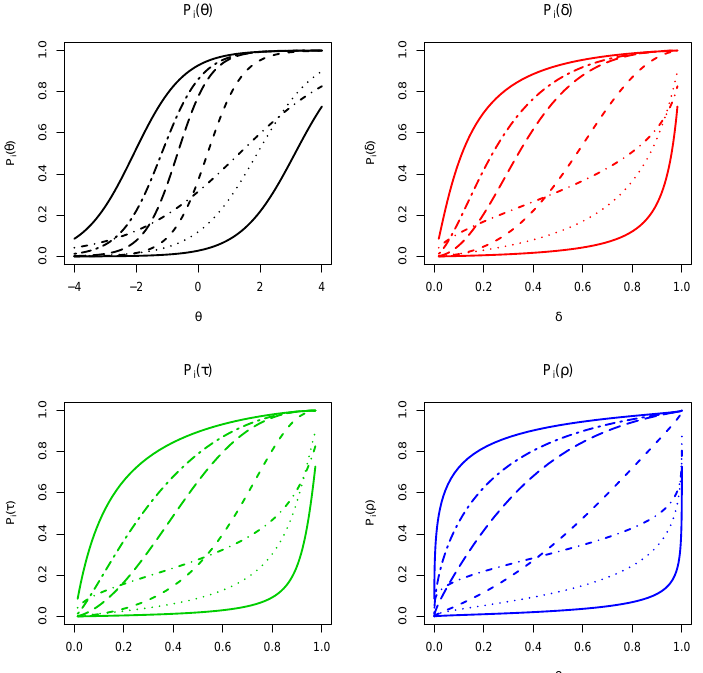
Figure A1. Item response functions of seven selected items from the PISA 2006 reading